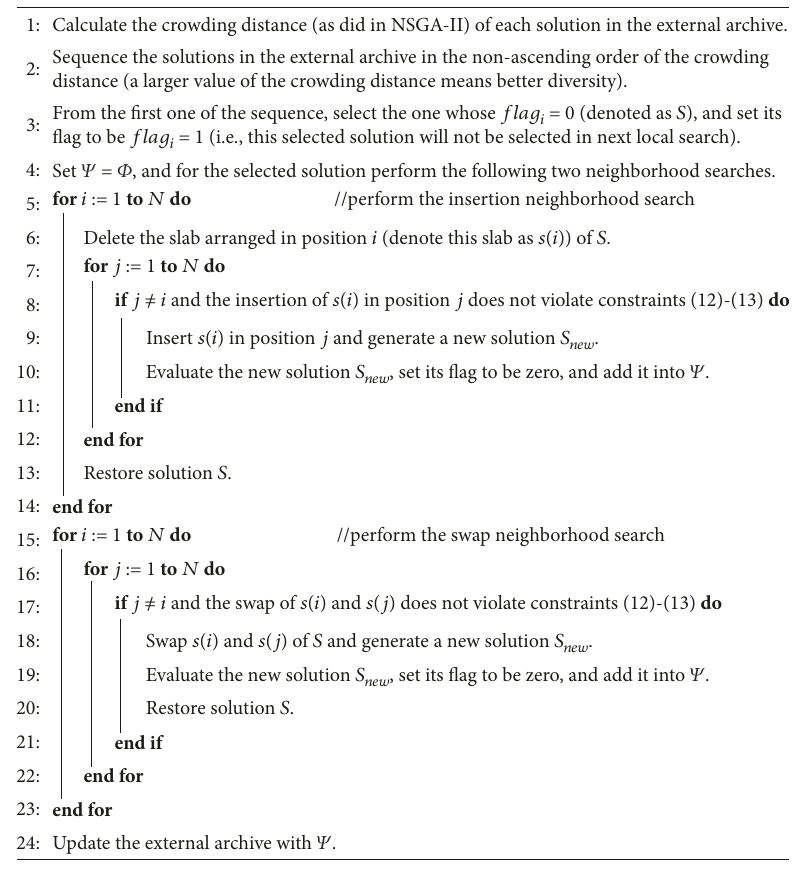
Figure 7: Procedure of the guided multiobjective local search.